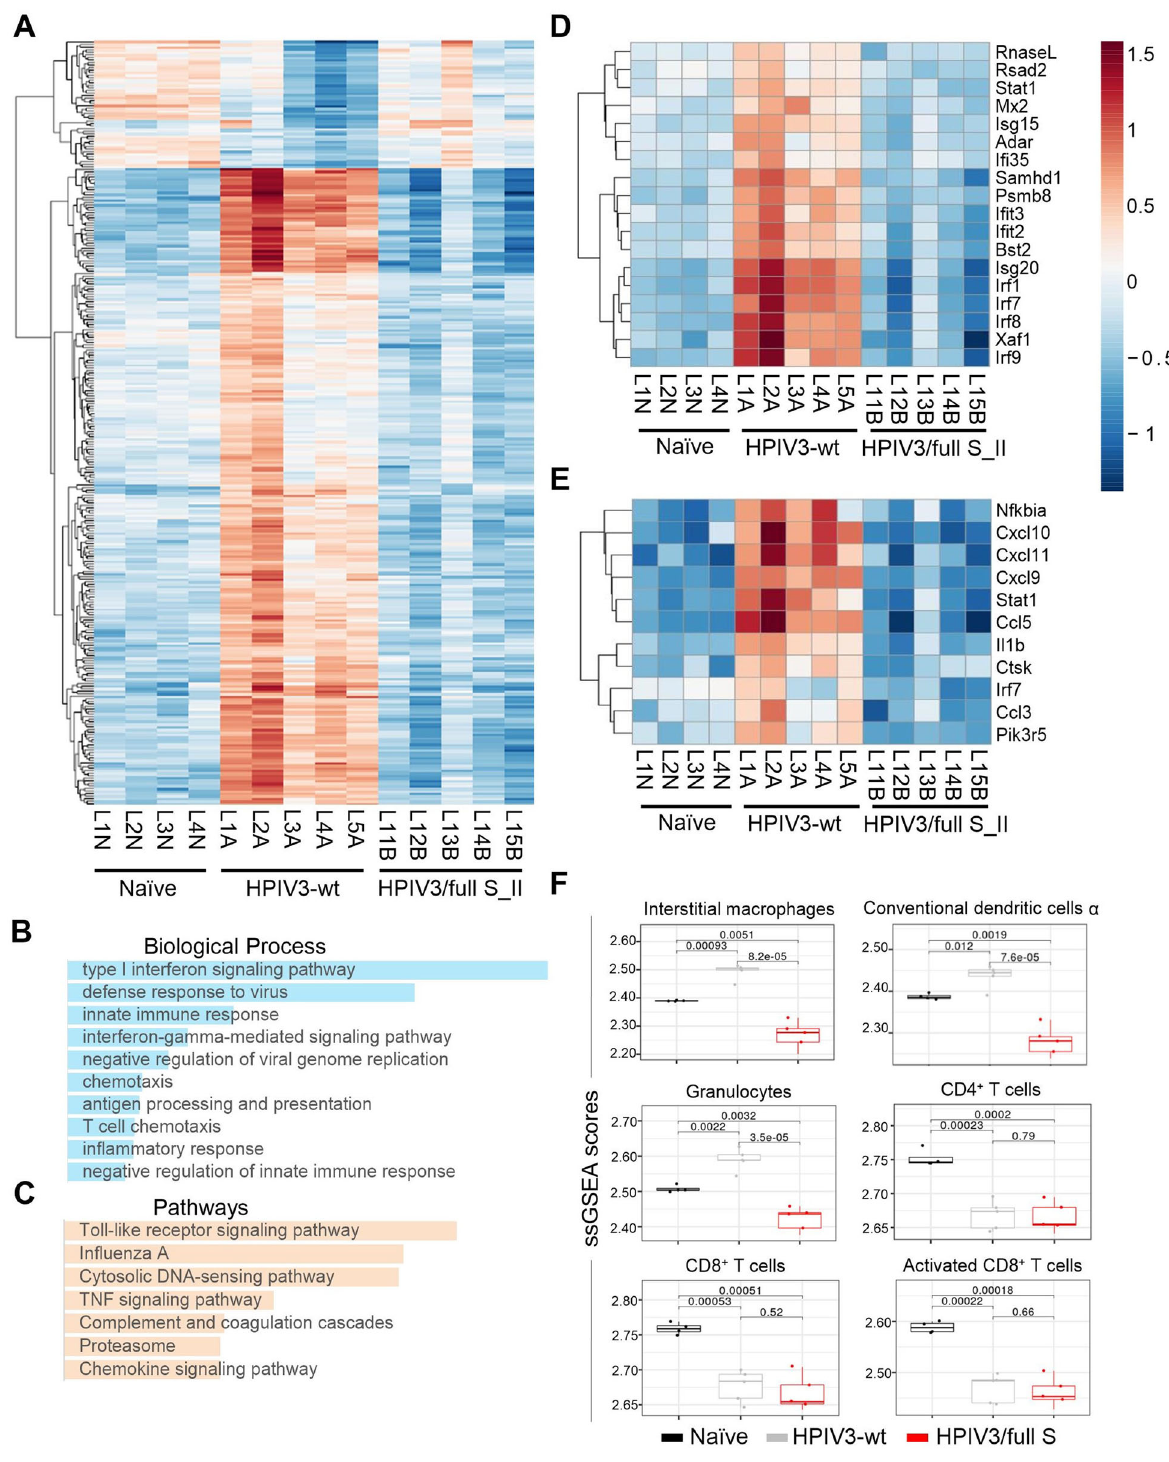
Fig. 7 Gene expression pattern in vaccinated hamsters at 3 dpi resembles that of naïve animals. RNA seq of lung tissue harvested from naïve animals (unvaccinated, uninfected), or at 3 dpi from HPIV3-wt or HPIV3/full S vaccinated hamsters, was performed. A Heat map of the top 300 differentially expressed genes with hierarchical clustering of genes is shown at the left. The color legend indicates log 2 expression measures. B , C Gene ontology enrichment analysis of differentially expressed genes upregulated in lungs of HPIV3-wt hamsters relative to HPIV3/full S vaccinated hamsters. D , E Heat map of top enriched GO category type I interferon signaling pathway ( D ) and toll-like receptor signaling pathway ( E ) . F Cell-type proportions of bulk RNA sequencing data. To evaluate changes in lung cellular composition across the animal groups, the single sample gene-set enrichment analysis (ssGSEA) was applied to quantify the relative abundance of different cell types across samples. ssGSEA scores were tested for differences between sample groups with a two-tailed T